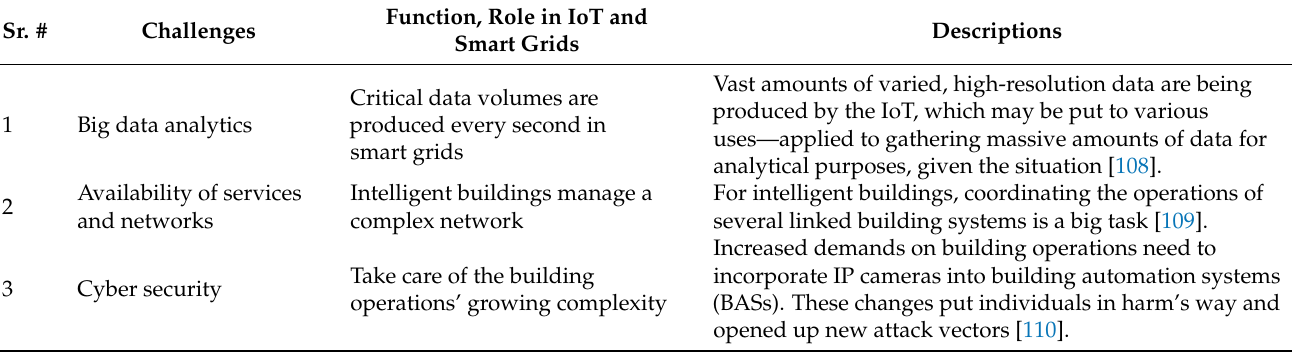
Table 5. Challenges in IoT-enabled smart